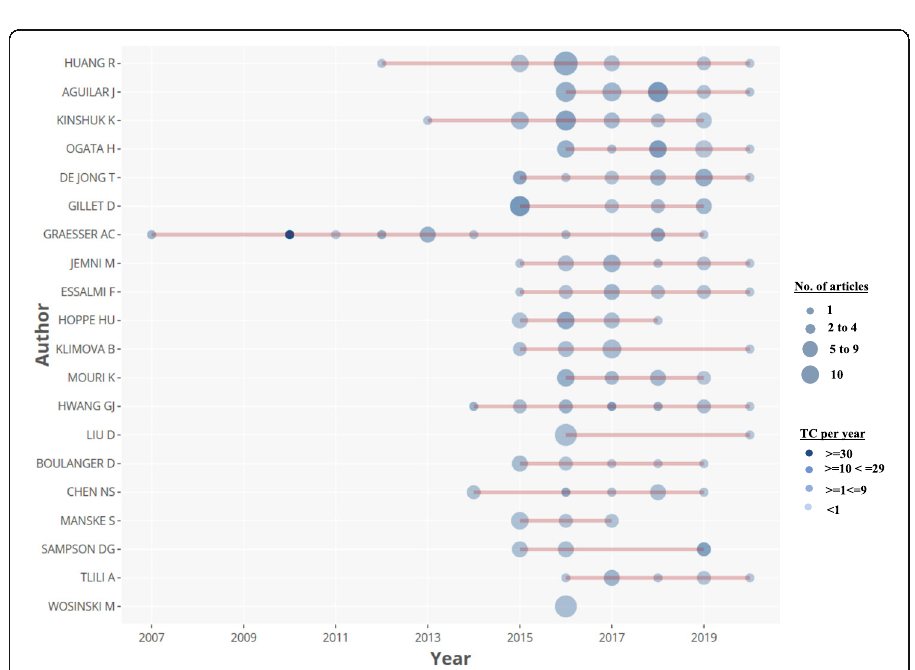
Fig. 4 Top 20 authors productivity over the years: the line represents an authors timeline; bubbles size is proportional to the number of documents produced by an author per year; the color intensity of the bubble is proportional to the total number of citations per year; the first bubble on the line indicates when the author began to publish in the field; the bigger the bubble, the higher the number of articles published an author per year; bubbles with deeper color intensity indicates higher citation